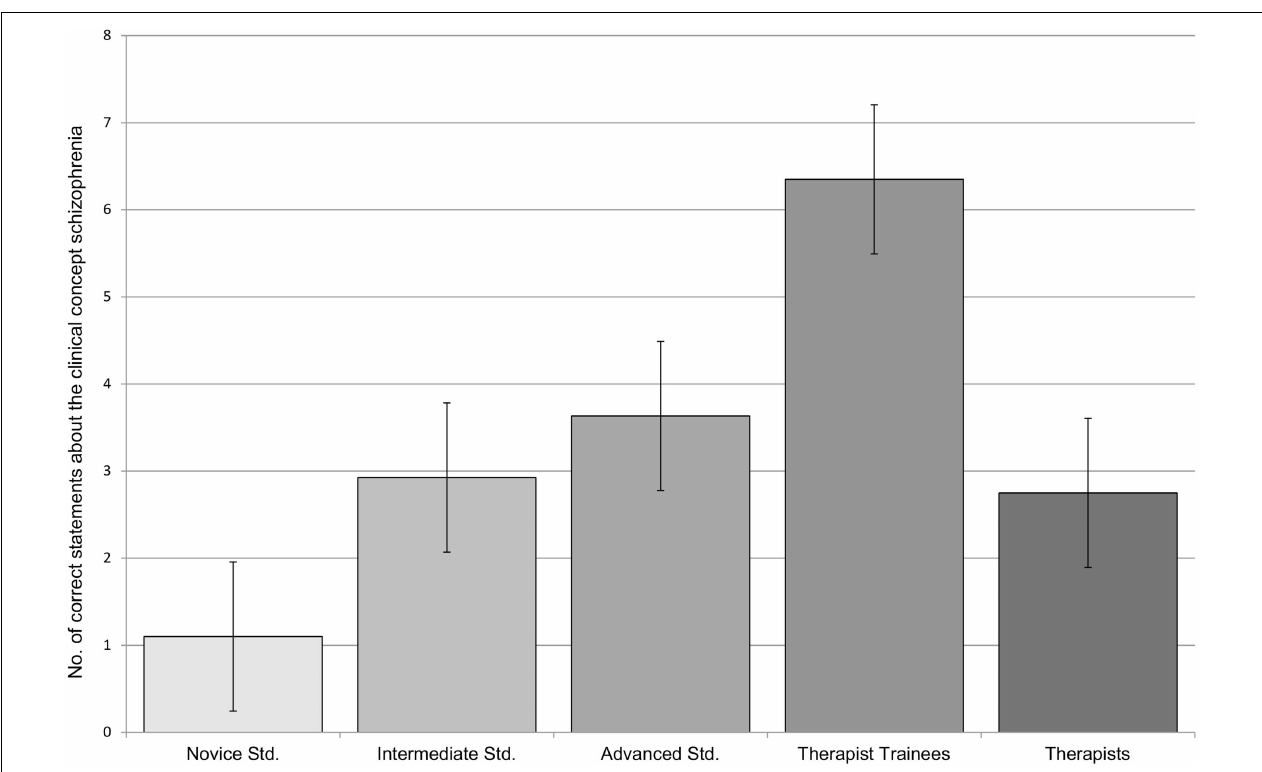
FIGURE 1 | Results (number of correct statements) for the open-format question regarding the clinical concept